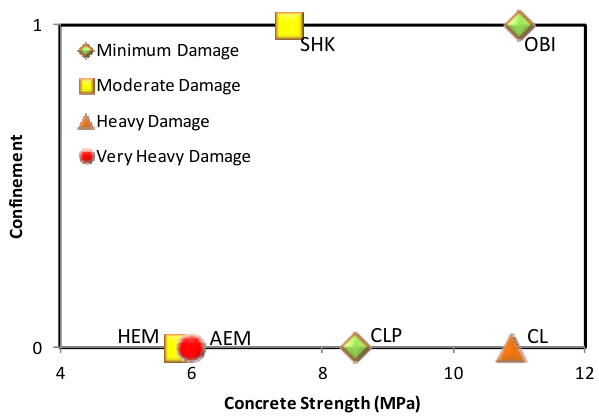
Fig. 6. Effect of concrete strength and confinement on damage level. 4